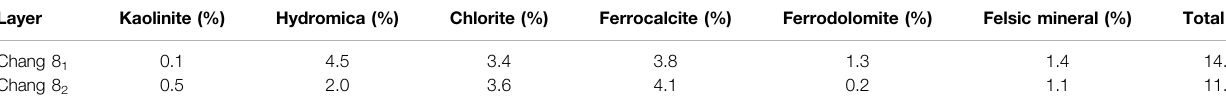
TABLE 2 | Interstitial fi lling content of Chang 8 reservoir in Wuqi – Zhijing – Ansai area. Layer Kaolinite (%) Hydromica (%) Chlorite (%)